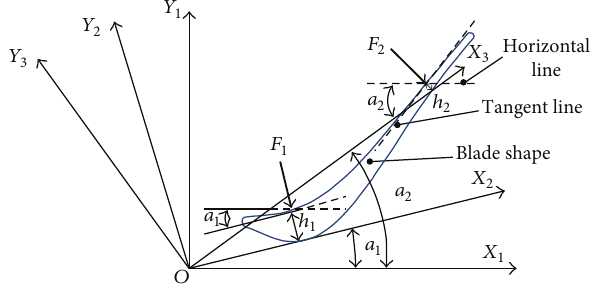
Figure 5: Instantaneous thickness in blade machining.